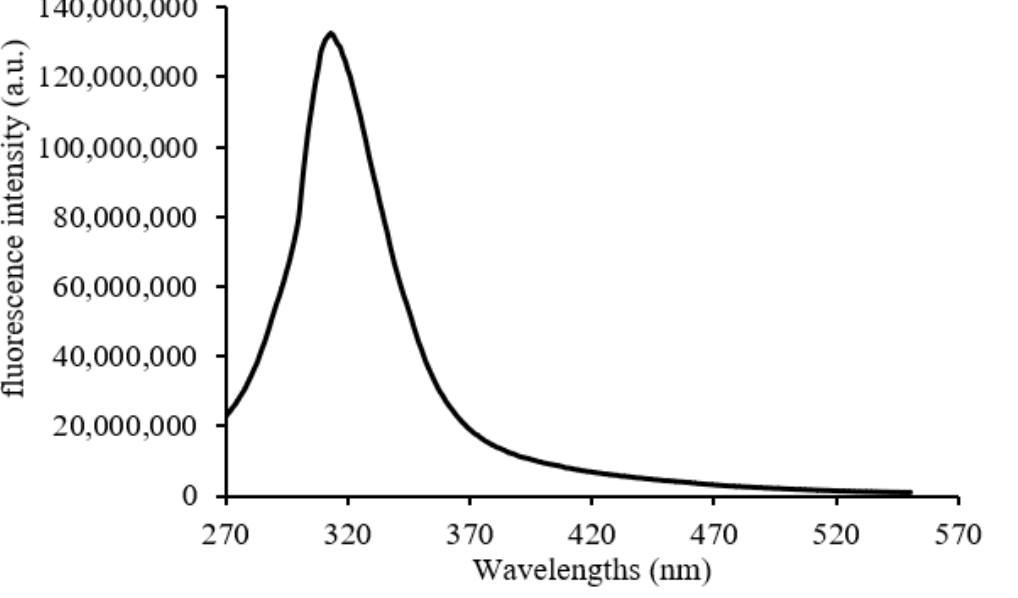
Figure 14. Luminescence emission spectra of C7 in D 2 O. C = 5 × 10 −5 mol·L −1 .